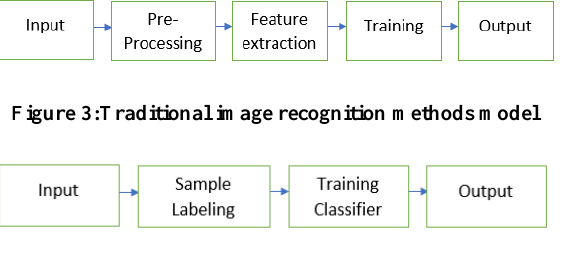
Figure 4: Convolutional neural networks model.